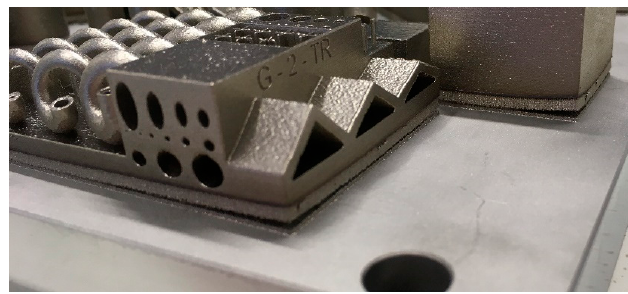
Figure 8. Delamination visible on the sample from company G.